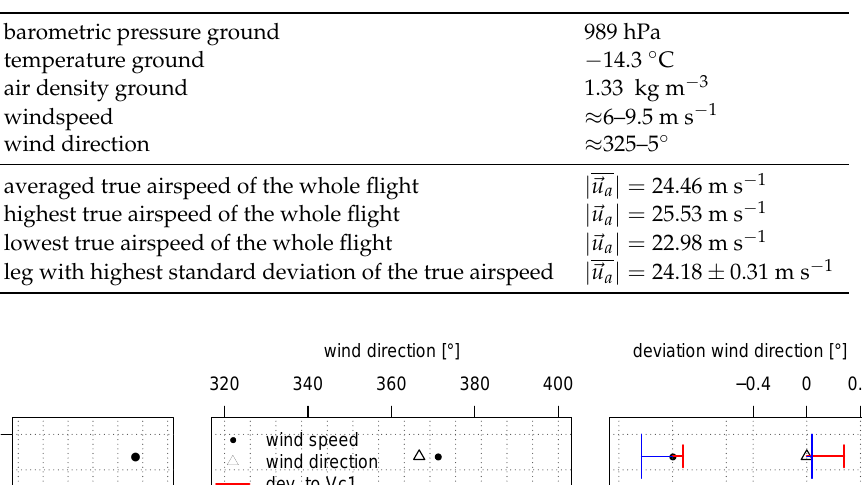
Table 2. Overview of the conditions during the ISOBAR flight.